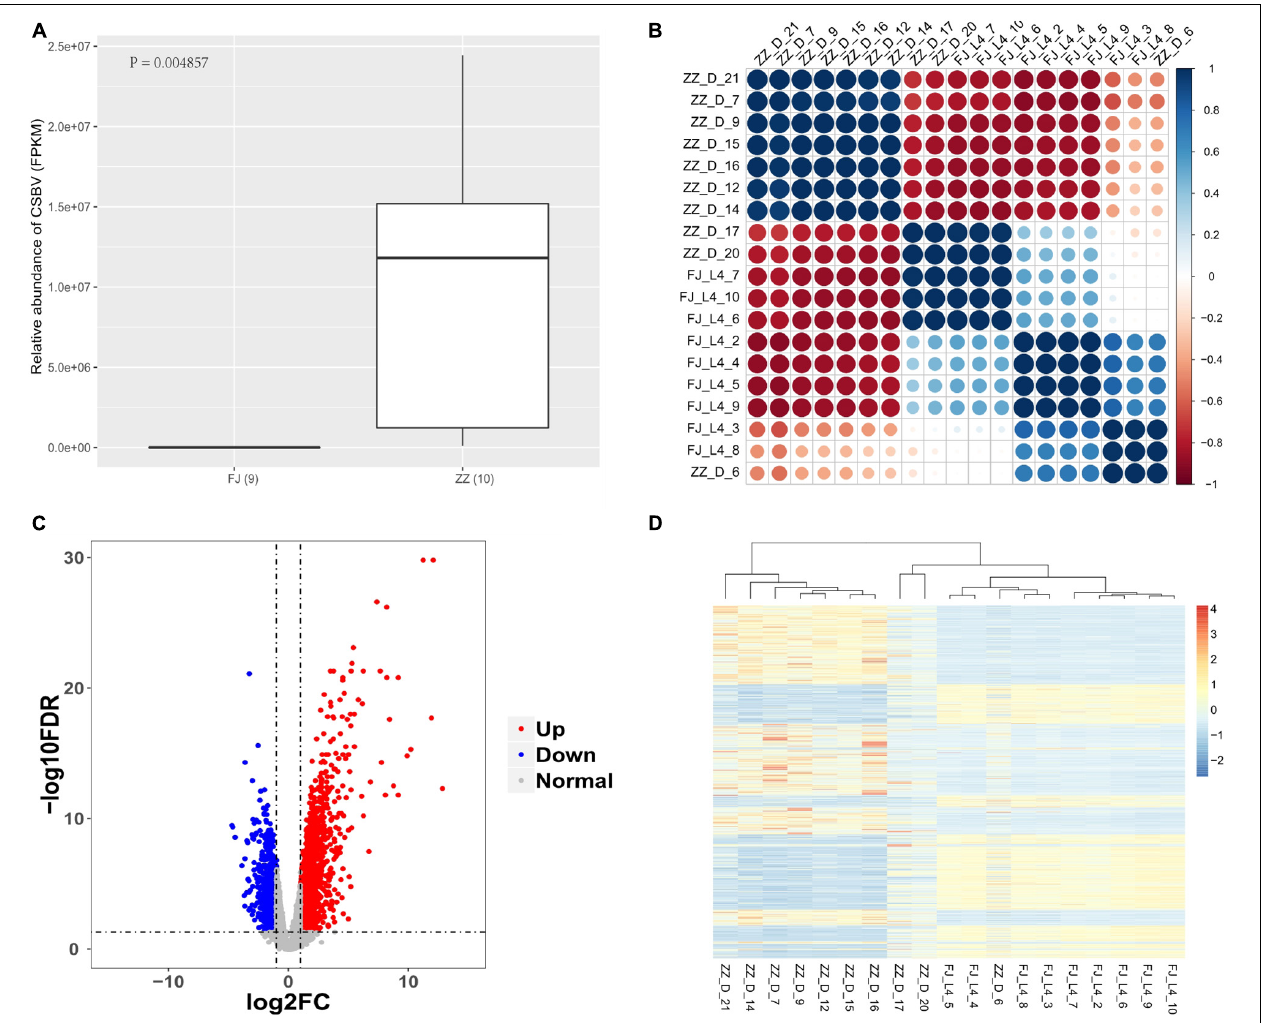
FIGURE 1 | Analysis of virus content and gene expression pattern in samples. (A) The FPKM of Sacbrood Virus between the infected group (ZZ) and the healthy group (FJ) ( P = 0.004857). (B) The correlationship of the samples. The correlation coefficient is more closer to absolute value of one, the similarity is higher among samples. The samples with bigger size, and darker color have more stronger correlationship to each other. The correlationship among the samples is calculated by the FPKM. (C) The volcano plot of the differentially expressed genes. The red dot is an upregulated gene, and the blue dot is a downregulated gene. The gray dot is a gene which has no significantly differentially expressed gene. The x-axis is the log of the fold change of FPKM which is between the treatment group and the control group. The y-axis is the negative log of the FDR. The FPKM is to standardize the relative abundance of expression of genes. The screening criteria for significantly differentially expressed genes are FDR < 0.05, and | log2(Fold change)| > 1. (D) The expression profile of the differentially expressed genes. The red color is upregulated, and the blue color is downregulated. The FPKM is to standardize the relative abundance of the gene expression. The z-score value with FPKM is used to draw the heatmap. The genes with P < 0.05 were used to cluster